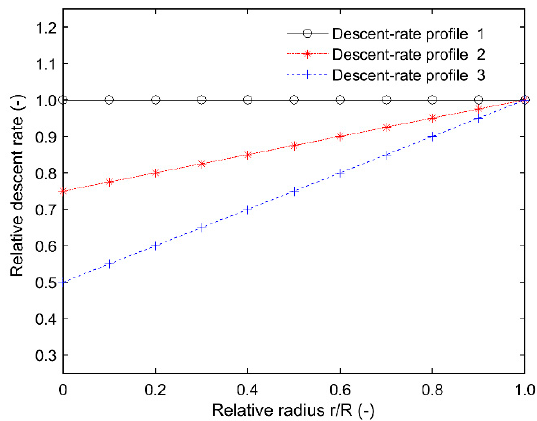
Figure 4. Three different descent-rate profiles at the stock line level.